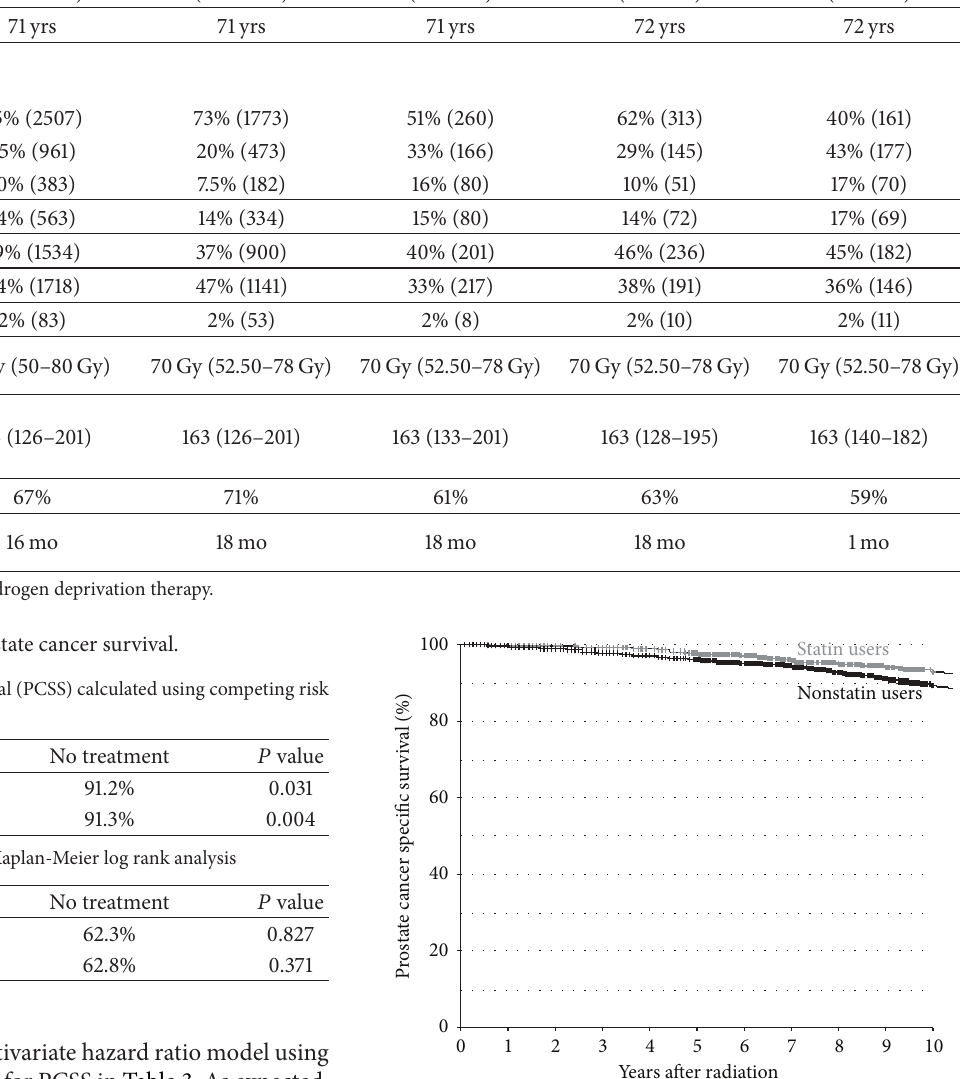
Table 1: Patient, tumor, and treatment characteristics in the entire cohort and according to use of statin and ASA. Characteristics